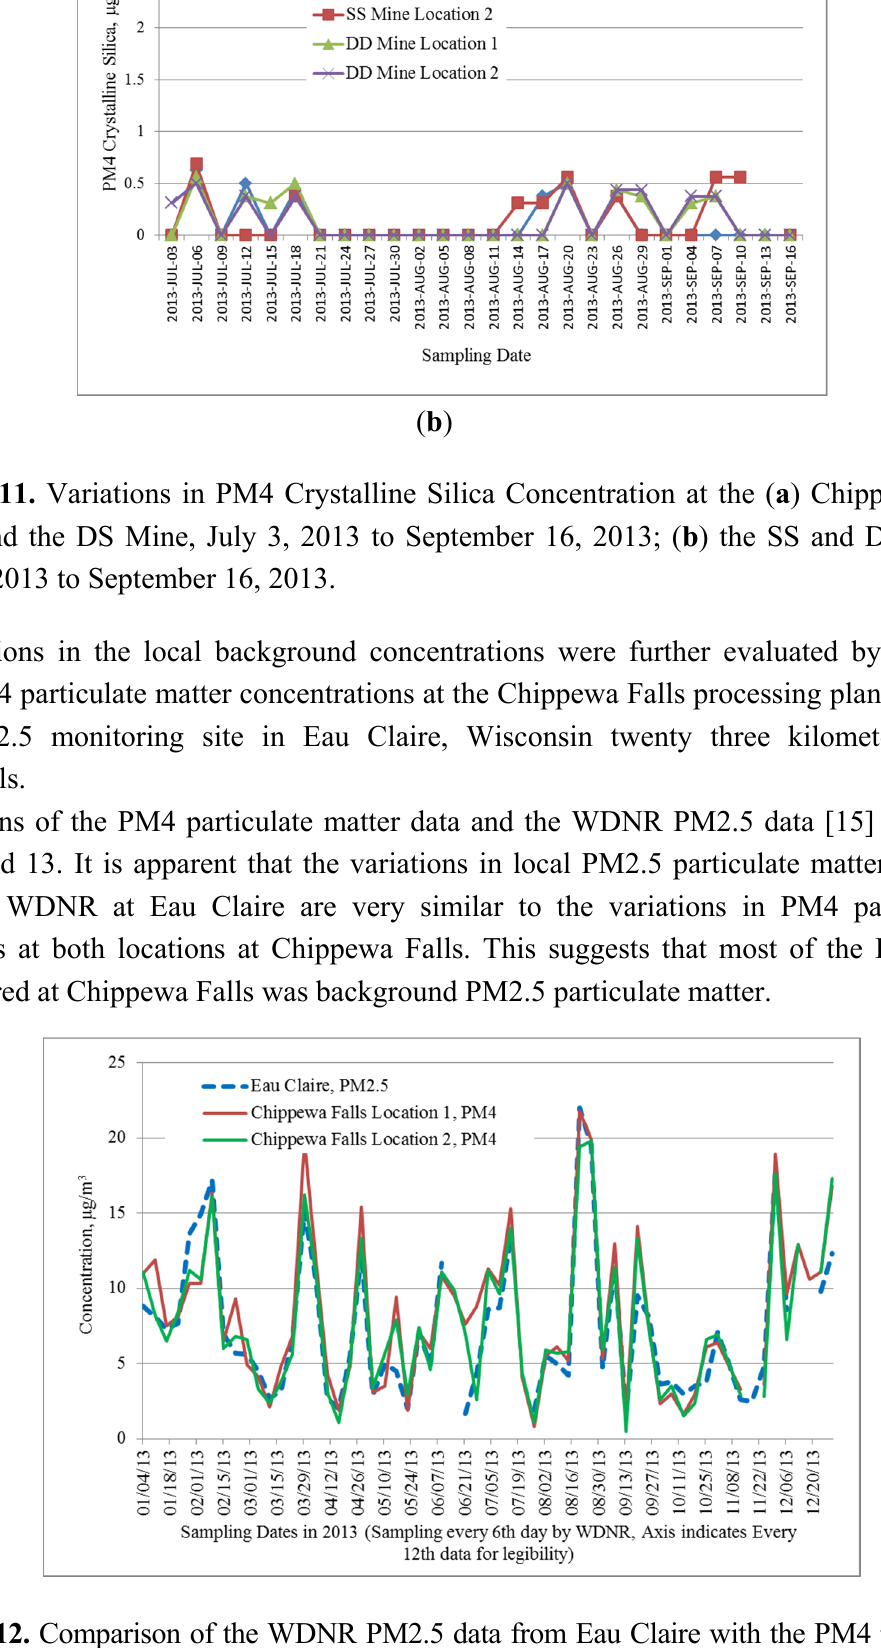
Figure 12. Comparison of the WDNR PM2.5 data from Eau Claire with the PM4 particulate matter data from Chippewa Falls Locations 1 and 2, October 2012–December